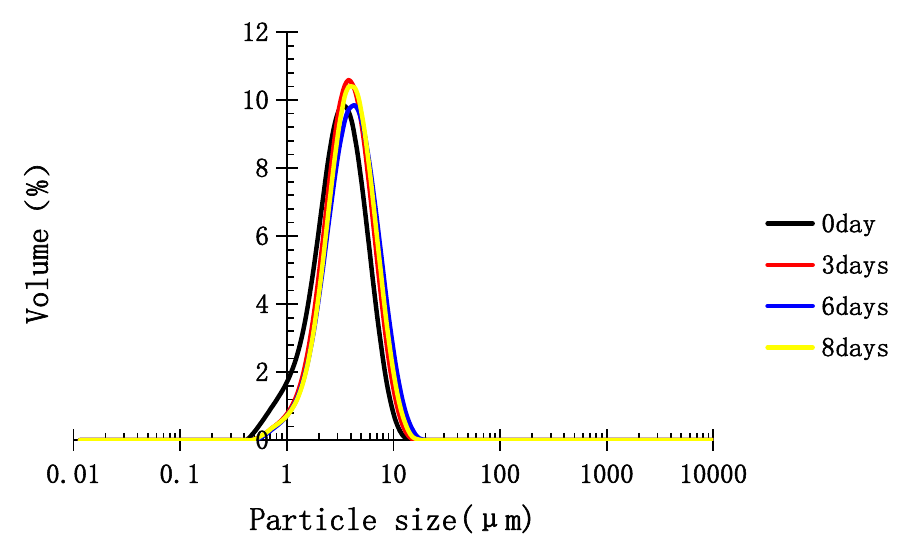
Figure 5. Particle size distribution (PSD) of medium-chain triglyceride (MCT) emulsion stabilized with TPC-A in the storage test at 25 ° C for a period of 8 days.